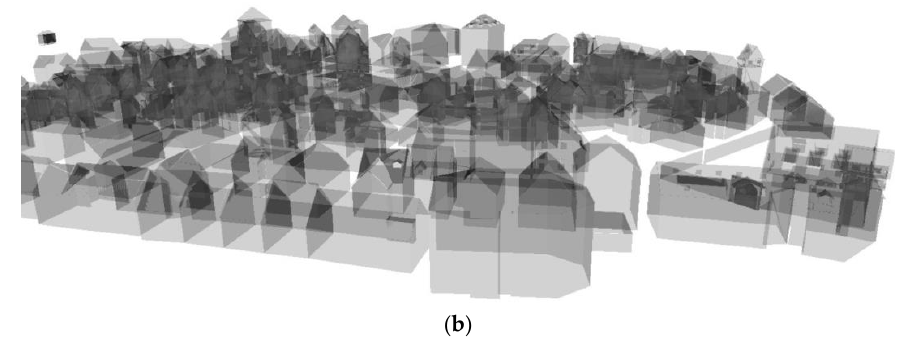
Figure 12. Transparency comparison of LOD3 and LOD3ES models. ( a ) LOD3 in transparency visualization; ( b ) LOD3ES in transparency visualization.